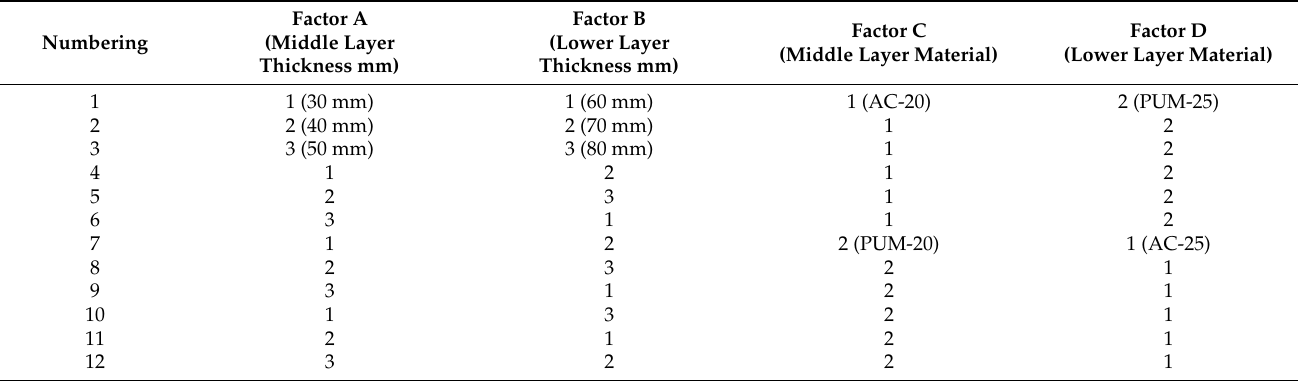
Table 3. Orthogonal test design of PU and asphalt composite pavement.